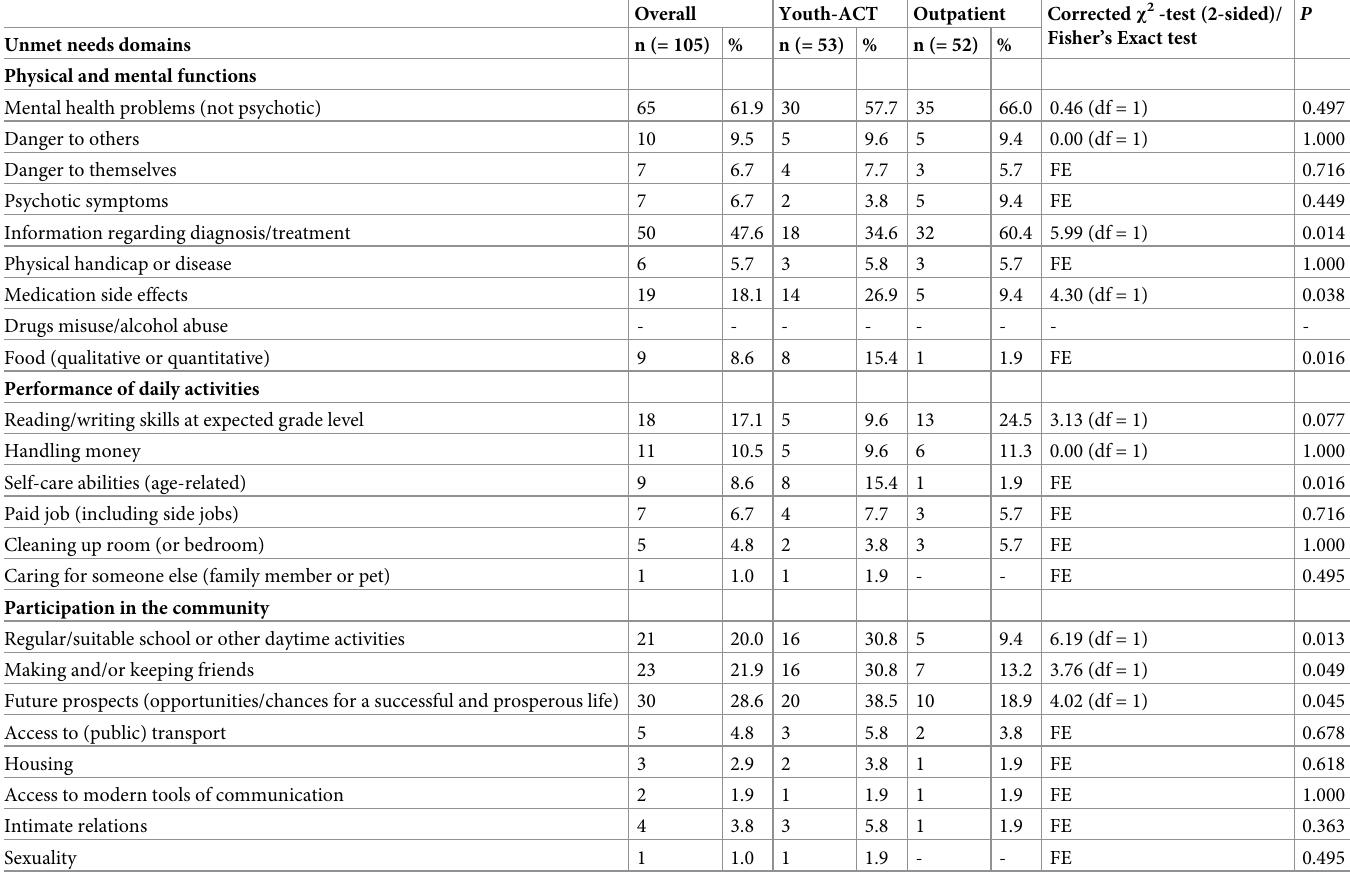
Table 2. Unmet Needs